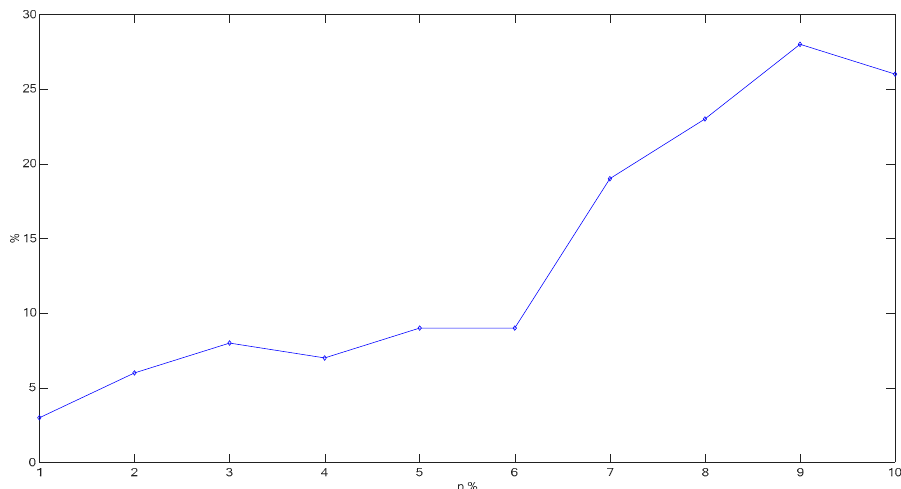
20 of 28 Figure 21. Boxplots of the statistical ensemble plotted versus the probability of long-range connections.